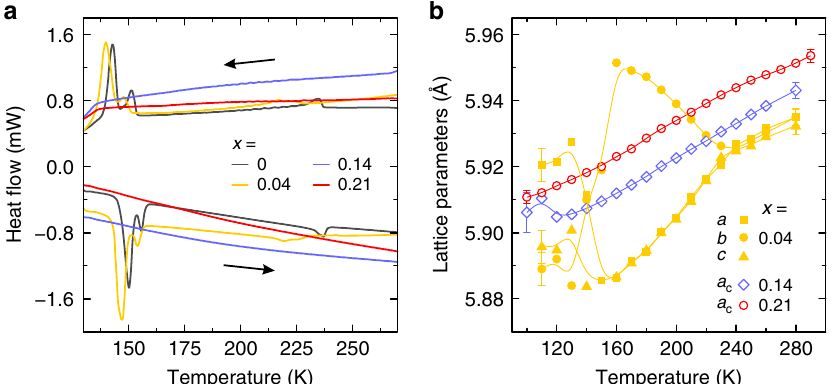
Fig. 1 Phase transition behavior of mixed MA 1 − x DMA x PbBr 3 perovskites. a DSC traces of x = 0, 0.04, 0.14 and 0.21 compounds obtained on cooling and heating. b Temperature dependence of the crystal lattice parameters of x = 0.04, 0.14 and 0.21 compounds determined by the single crystal XRD. The curves in b are guides for